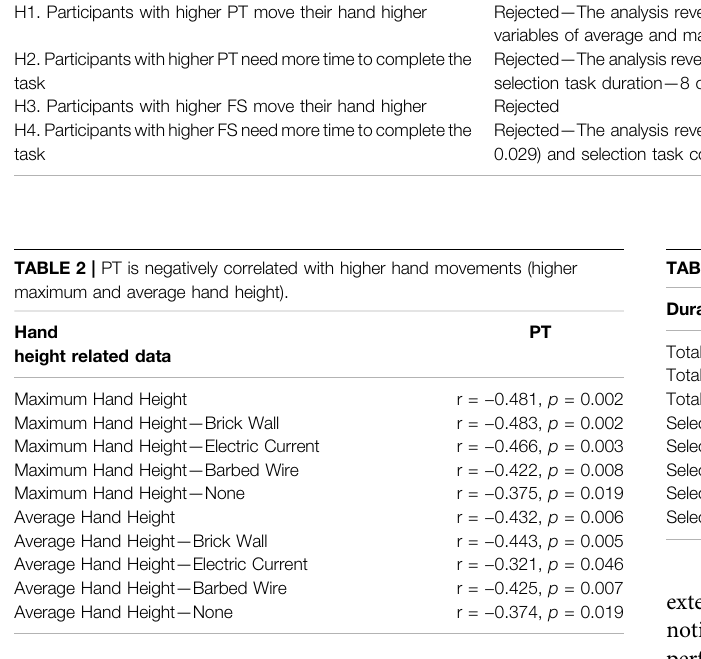
TABLE 1 | RQ1 related hypotheses results summary: Exploring the correlation between PT and FS and logged data. Hypotheses